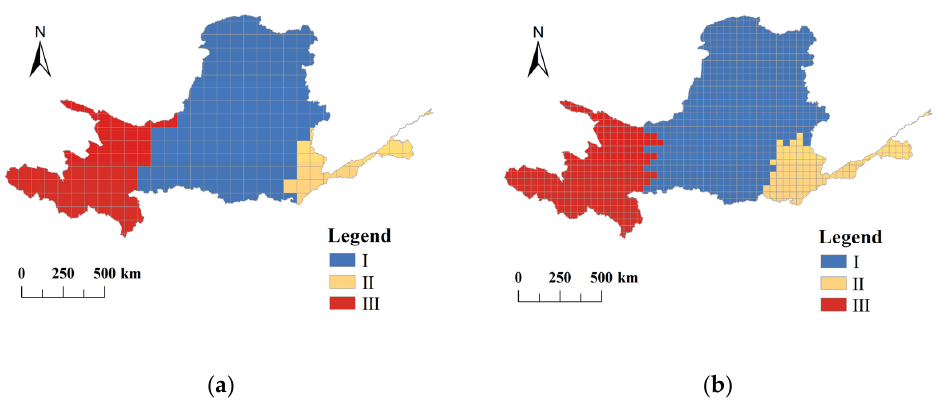
Figure 5. Clustering results of the Yellow River Basin. ( a ) Clustering results at an 80 km scale; ( b ) Clustering results at a 40 km scale.